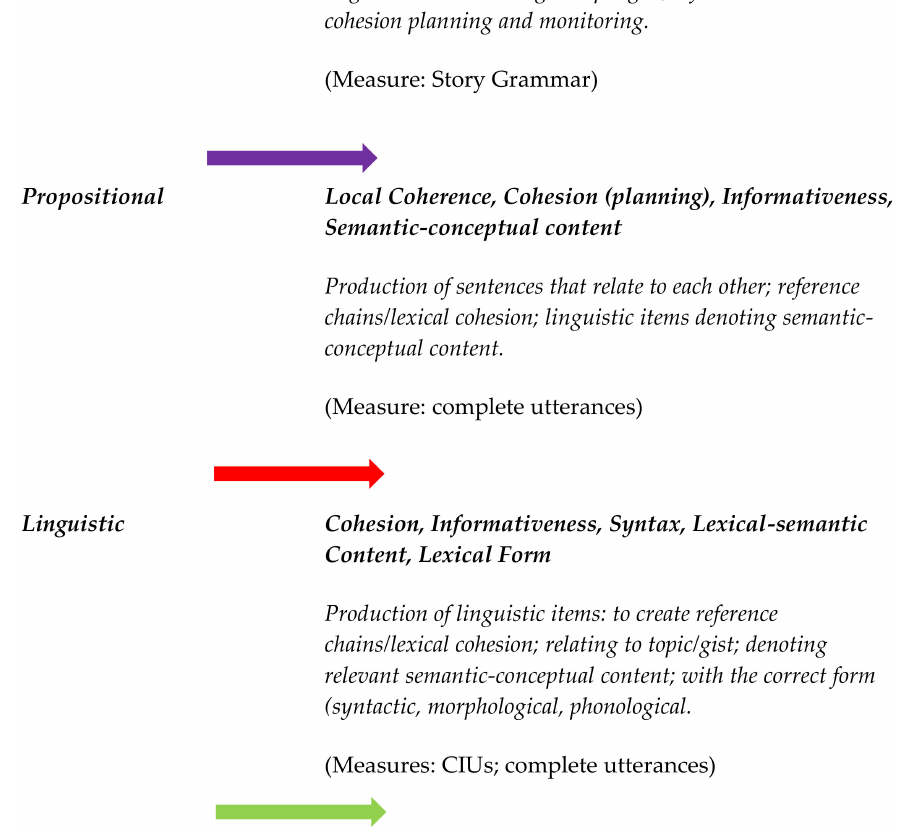
Figure 3. An example of the use of the LUNA framework: mapping skills, constructs and the three most commonly used discourse